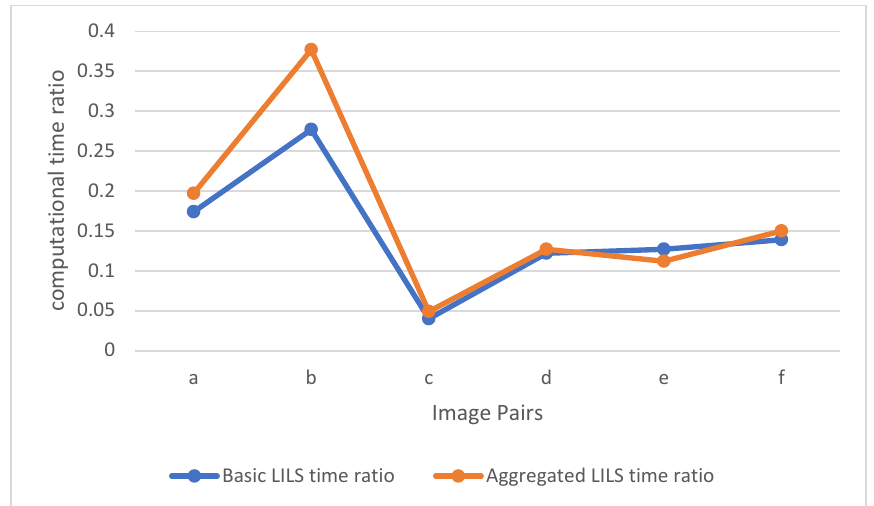
Figure 3. Ratio of the computational time with respect to MSAC for the first dataset.